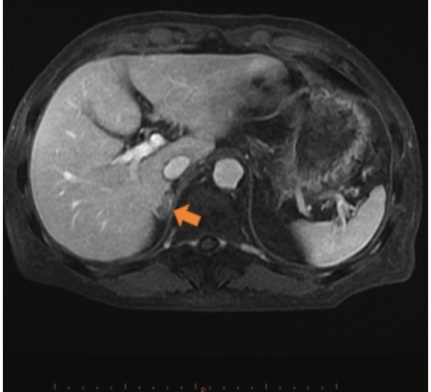
Figure 1: Enhanced MRI showing a bladder tumor at the left wall (arrow). Arrow head shows urethral balloon catheter.